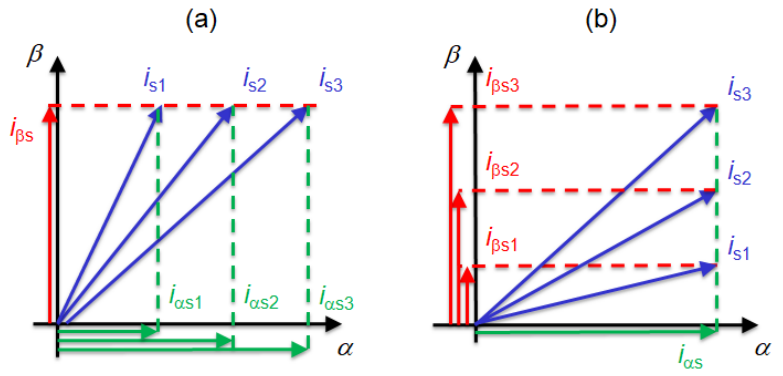
Figure 13. Graphical interpretation of the stator current components oriented in the rotating coor- dinate system αβ : i α s ( a ) and i β s ( b ).